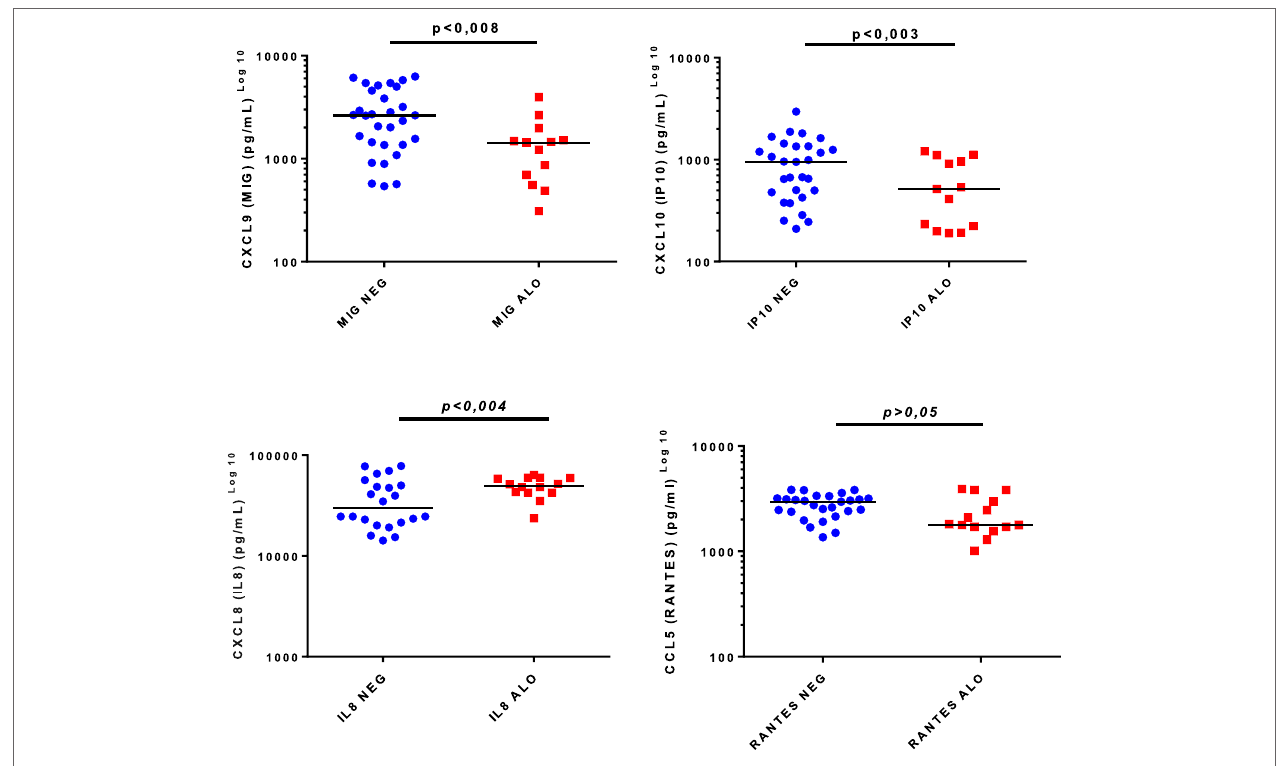
FigUre 1 | Chemokines and maternal RhD alloimmunization. Alo: RhD-negative women with maternal alloimmunization (IAT + ); NEG: RhD-negative women without maternal alloimmunization (IAT −